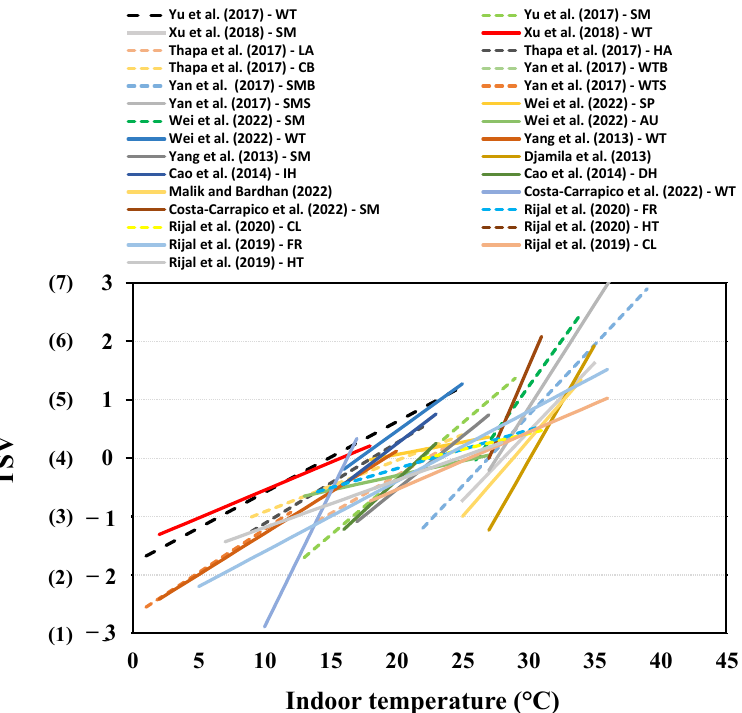
Figure 6. Regression line for TSV and indoor air temperature [6,7,19,20,22–24,33,39,40,47,74,75].